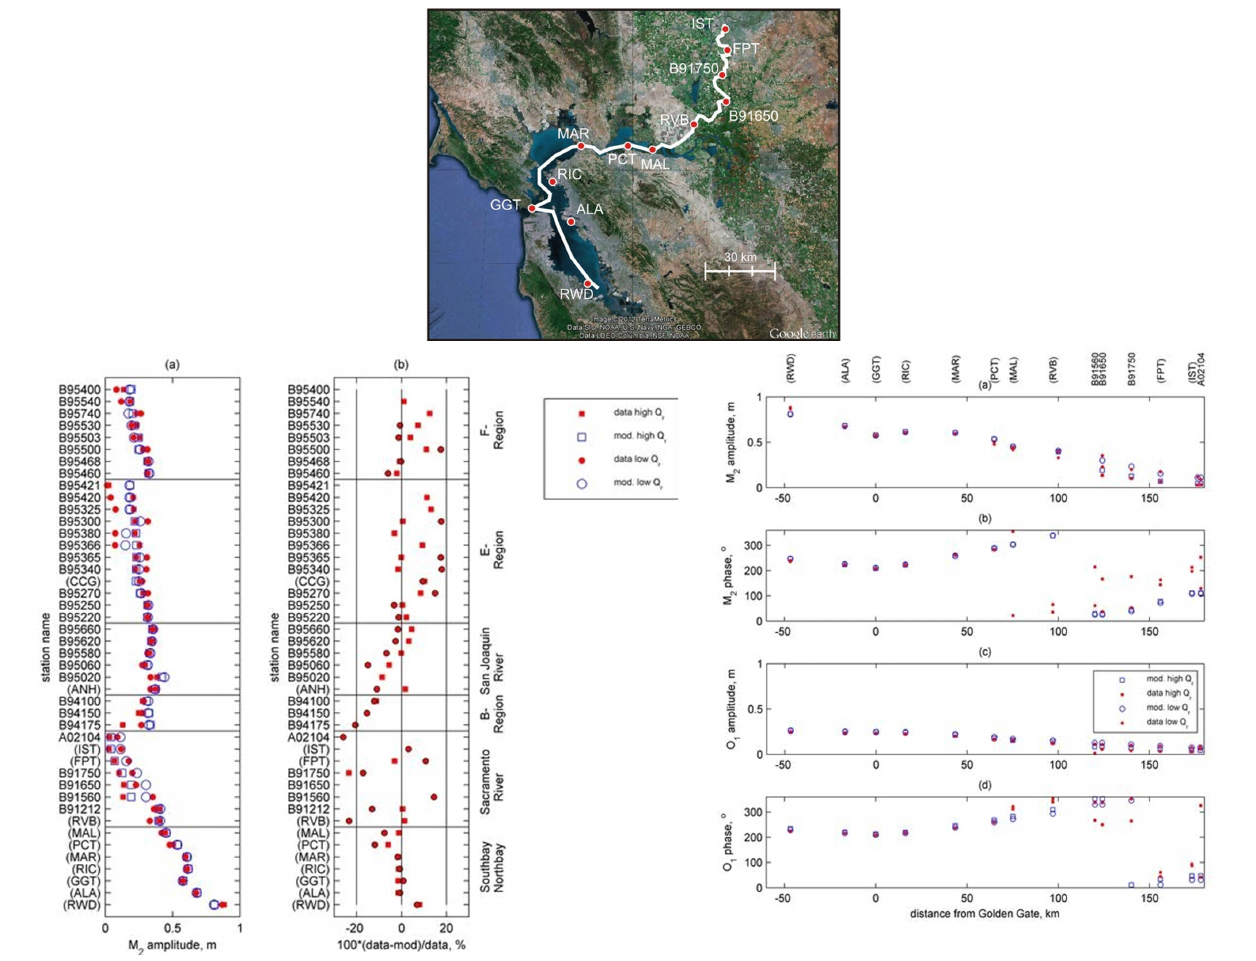
Figure A1. Hydrodynamic calibration